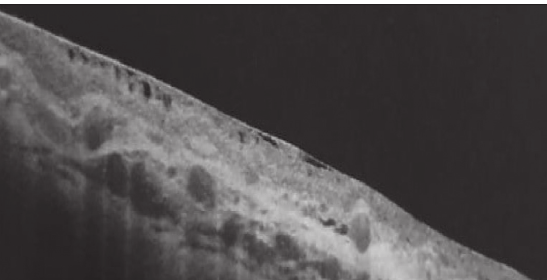
Figure 4: AS-OCT bleb imaging of a female patient in group I during the hypertensive phase at 3 months; IOP was 26 mmHg. AS-OCT revealed the presence of diffuse multicystic bleb cavity, diffuse hyporeflective conjunctiva with hydration, and intraconjunctival cysts. Maximal bleb wall thickness was 580 μ m, and bleb wall reflectivity was 103.